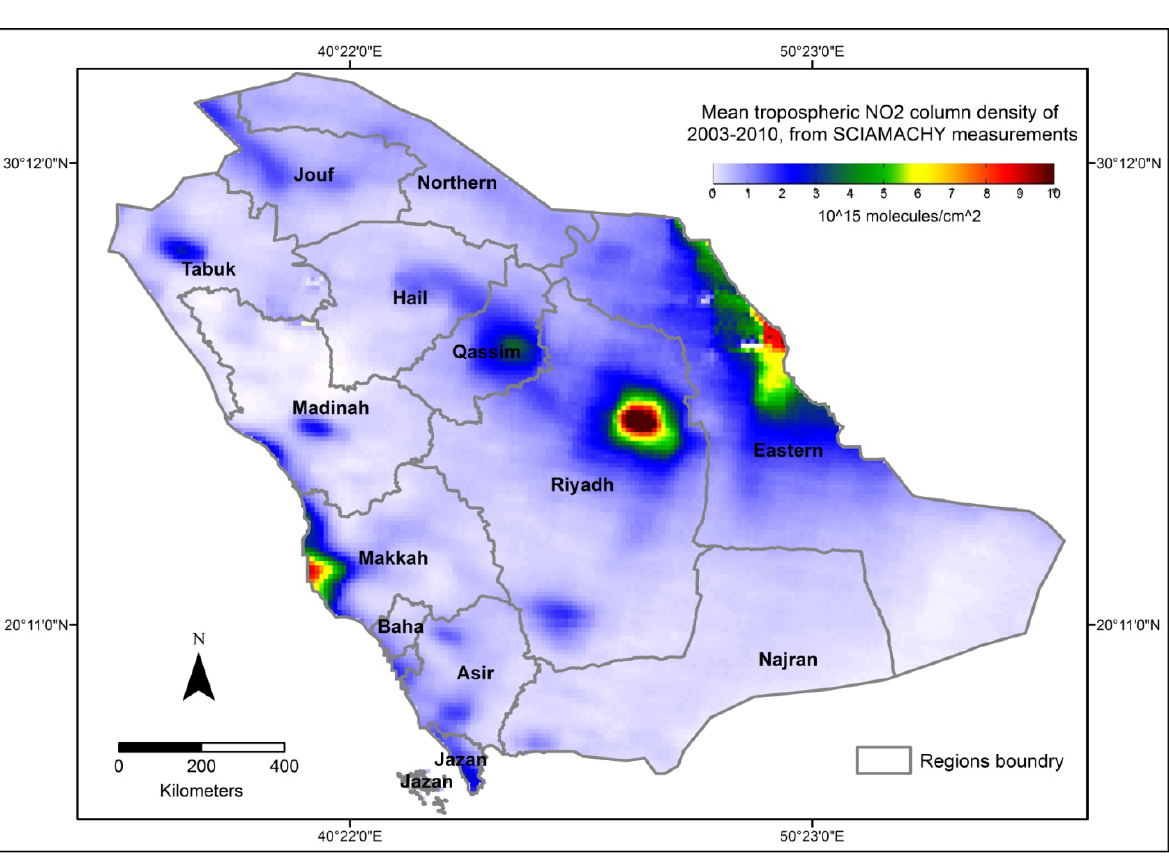
Figure 1. Distribution of mean tropospheric NO